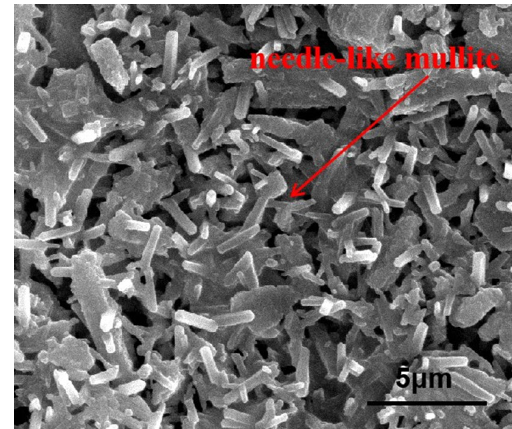
Fig. 2 Schematic diagram of filtration experimental equipment: 1-centrifugal pump; 2- needle valve; 3- flow meter; 4- pressure gage; 5- temperature meter; 6- plate membrane module; 7- stock tank